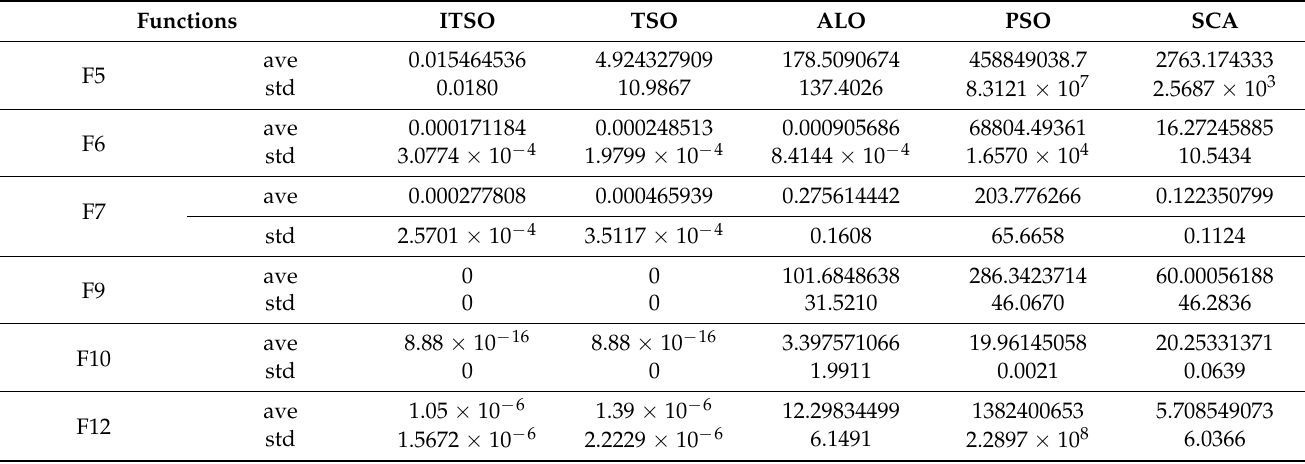
Table 3. Mean and standard deviation of